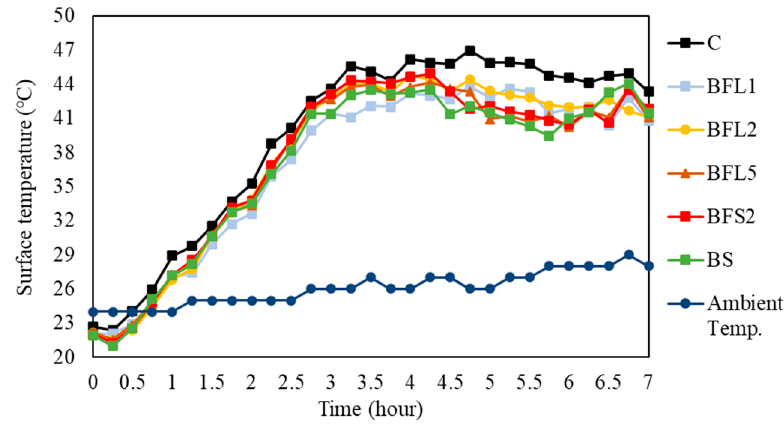
Figure 9. Surface temperature of the interlocking blocks (base layer).